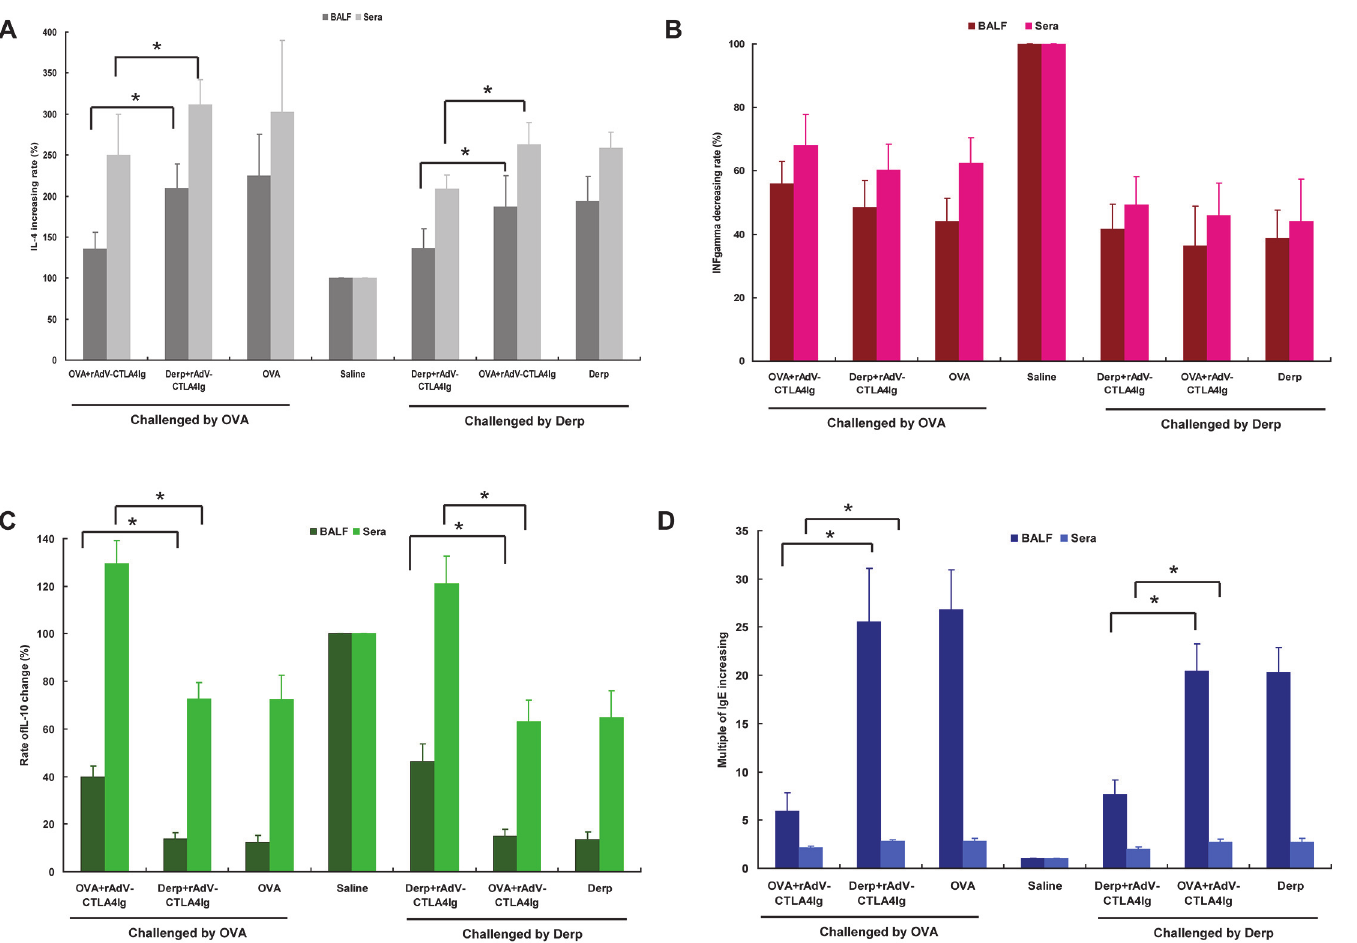
increasing rates of IL-4 in the regimens of sensitization, challenge, and treatment. B, IFN- γ decreasing rates in the regimens of sensitization, challenge, and treatment. C, IL-10 changes in the regimens of sensitization, challenge, and treatment. D, the increasing rates of IgE in the regimens of